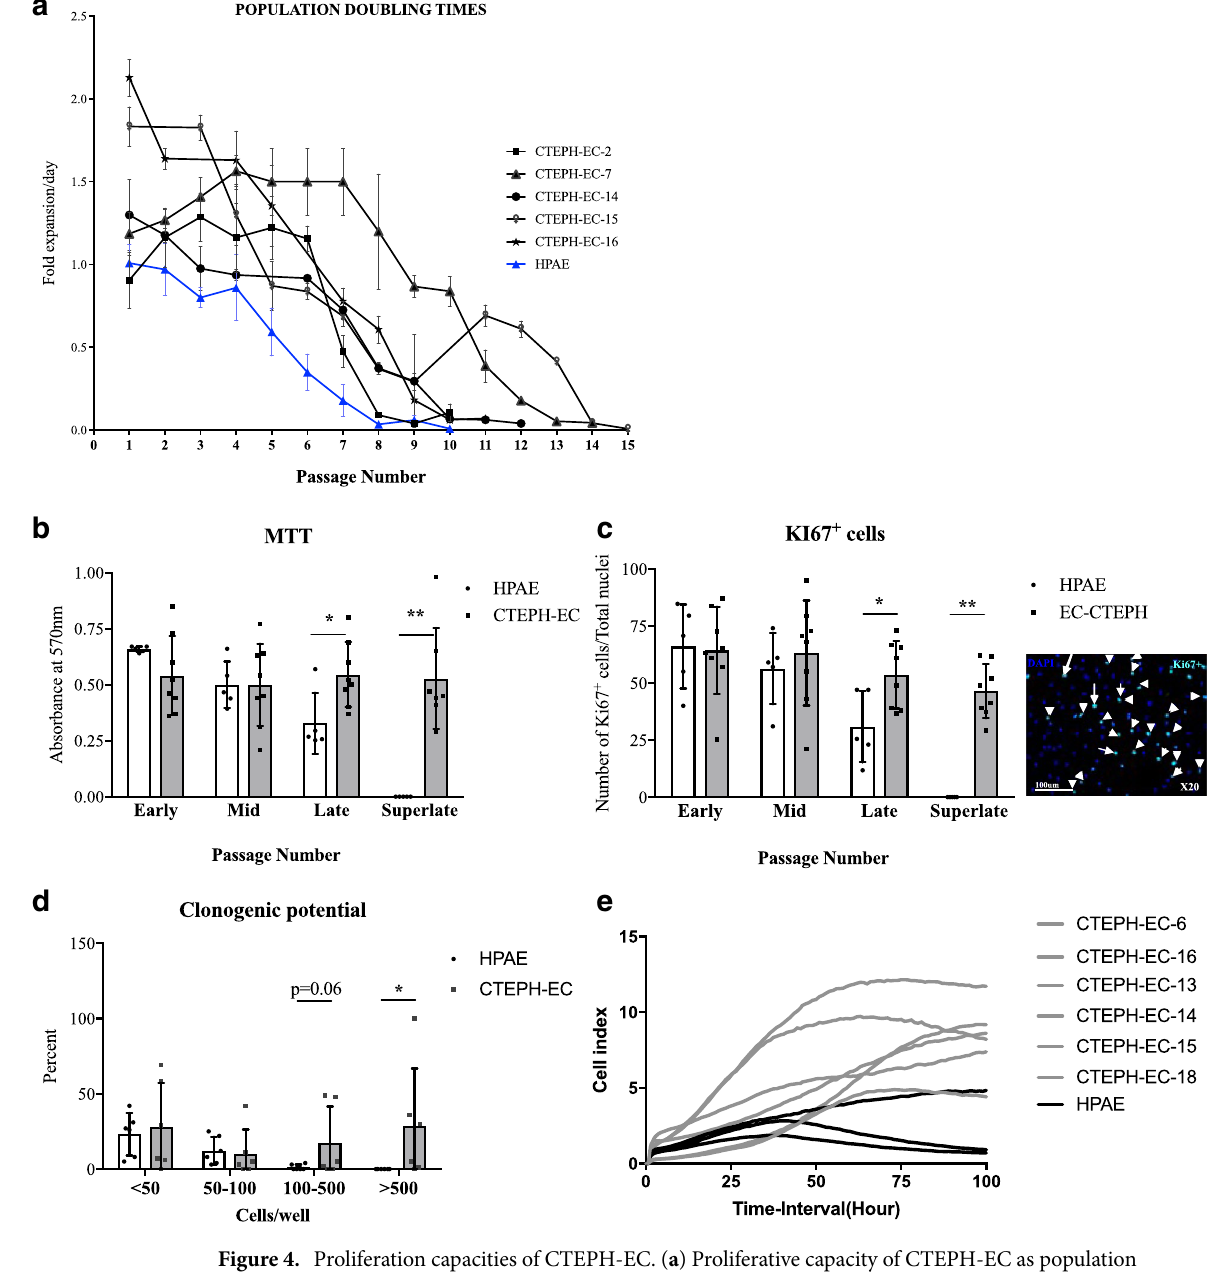
Figure 4. Proliferation capacities of CTEPH-EC. ( a ) Proliferative capacity of CTEPH-EC as population doubling time. n = 3 HPAE, CTEPH-EC, n = 5 independent experiments performed in triplicate ( b ) Viability of CTEPH-EC compared to HPAE evaluated by MTT assay. Values expressed as mean ± SD, n = 5 HPAE, n = 8 CTEPH-EC independent experiments performed in triplicate, p < 0.05*, p < 0.01**, Mann–Whitney U test. ( c ) Quantification and stain of proliferative marker Ki-67 in CTEPH-EC and HPAE at different passages. Values expressed as mean ± SD, n = 5 HPAE, n = 8 CTEPH-EC; independent experiments p < 0.05*, p < 0.01**, Mann–Whitney U test, ( d ) Clonogenic potential of CTEPH-EC expressed in percentage. Values expressed as mean ± SD, n = 6 HPAE, n = 6 CTEPH-EC; independent experiments, p < 0.05*, Mann–Whitney U test. ( E ) Cellular adhesion of CTEPH-EC compared to HPAE. n = 3 HPAE, n = 6 CTEPH-EC. Statistical analysis was performed with GraphPad Prism 7 software, version 7.0e, serial number:GP7-0633739-R###-#####, https:// www. graph pad.